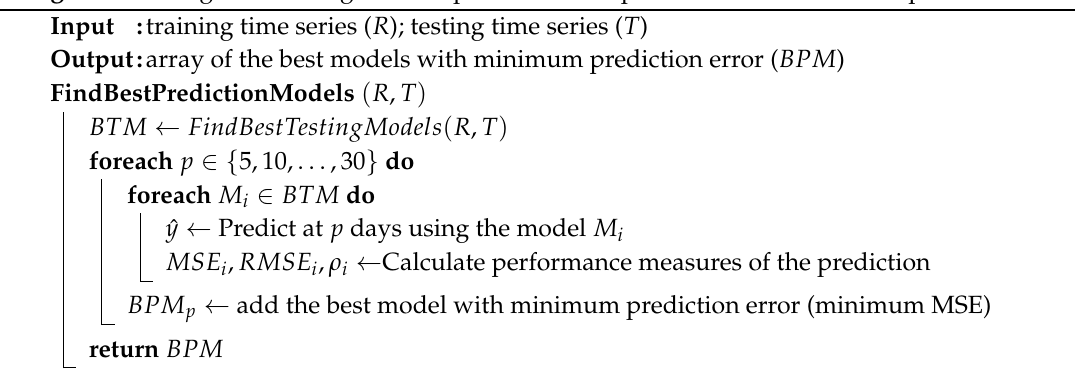
Algorithm 2: Algorithm design for the prediction and performance measures